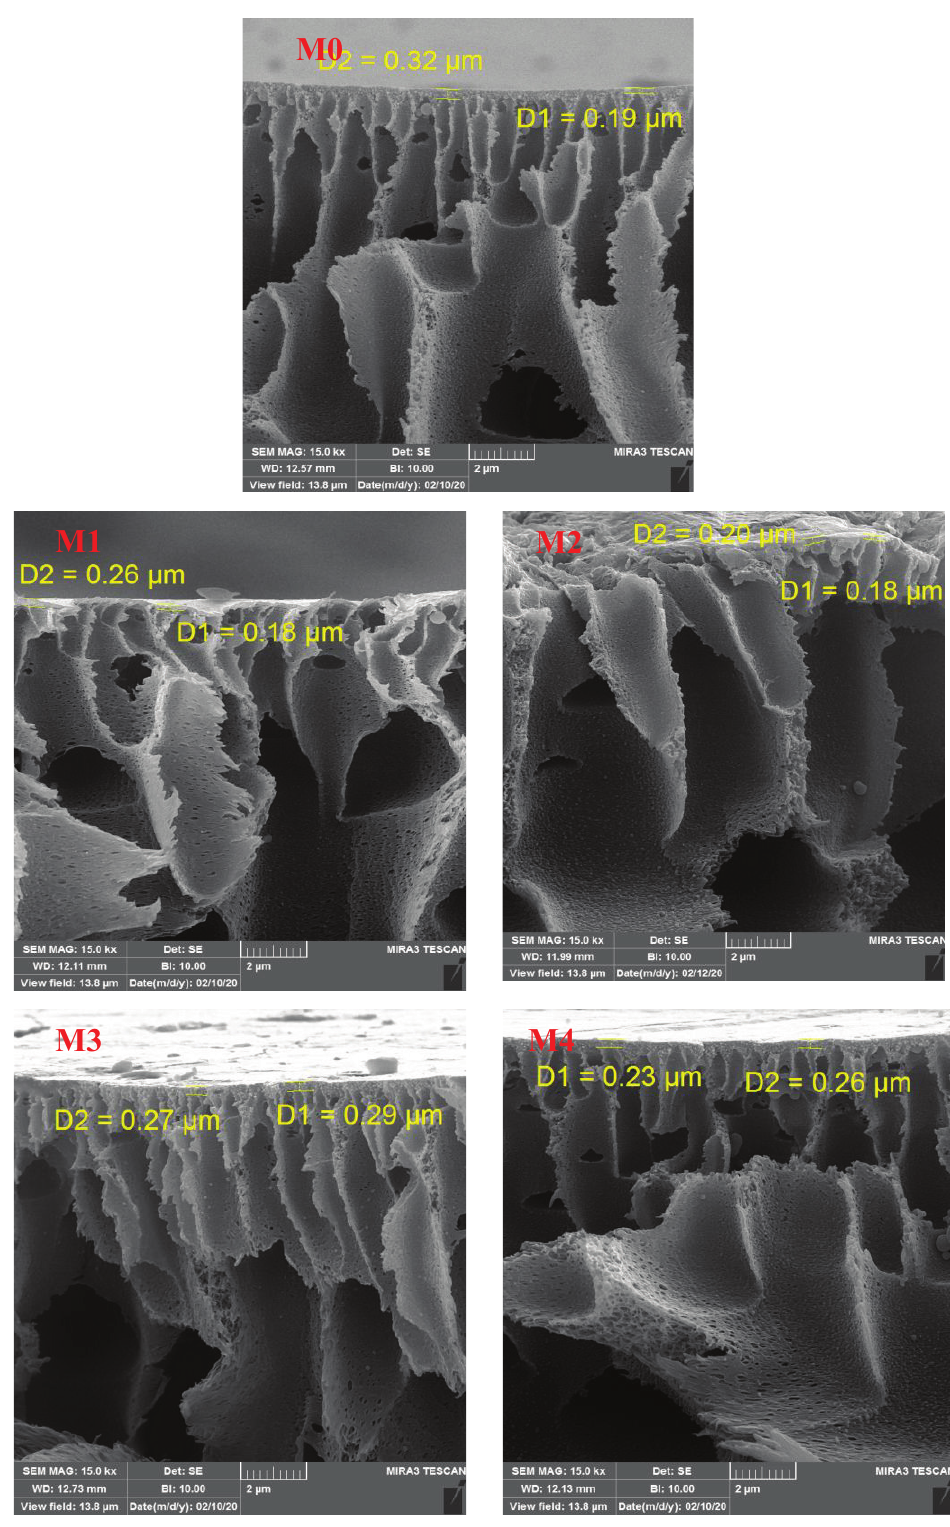
O membranes (M1-M4).. 2 4 surface images of the pure PES membrane and modified membranes at 1 wt% of nanoparticle are shown in Figure 7 at scanning area 6 × 6 μm. Moreover, the